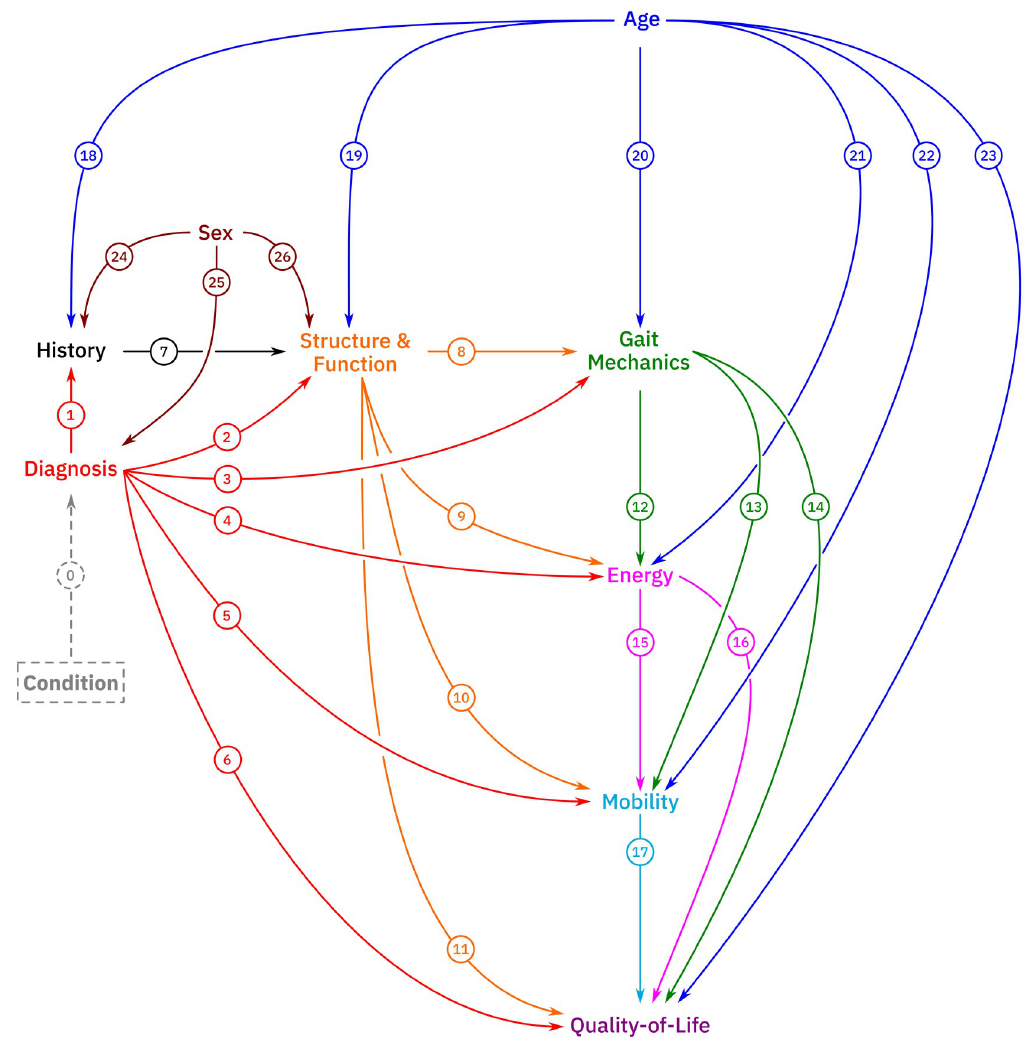
Fig 1. The proposed causal model in schematic form. The proposed model nodes include Condition (latent) , Diagnosis , History , Age , Sex , Structure and Function , Gait Mechanics , Mobility , Energy , and Quality-of-Life . Extensive details of proposed nodes are found in the text. Descriptions of the paths are found in S1 Appendix. A full implementation of the model ( Rmarkdown file) and a de-identified dataset can be found in the S1